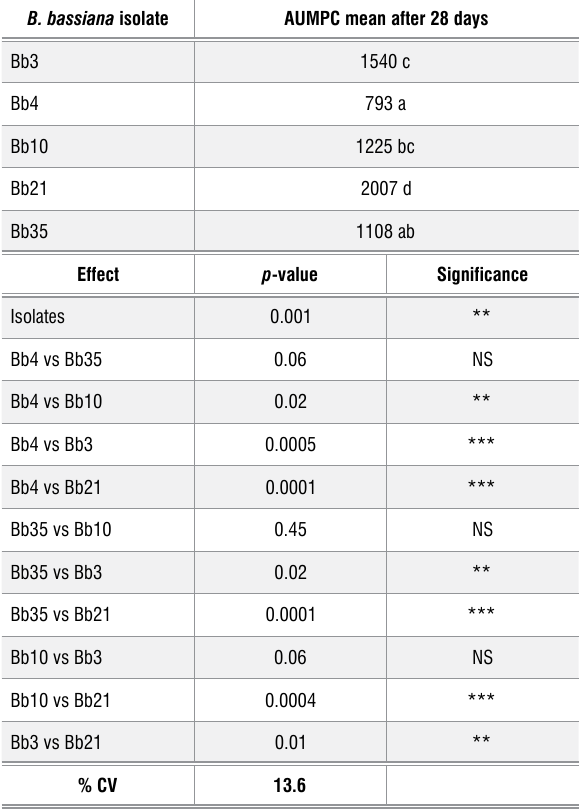
Table 3: Evaluation of the pathogenicity of five Beauveria bassiana strains against Sesamia calamistis B. bassiana isolate